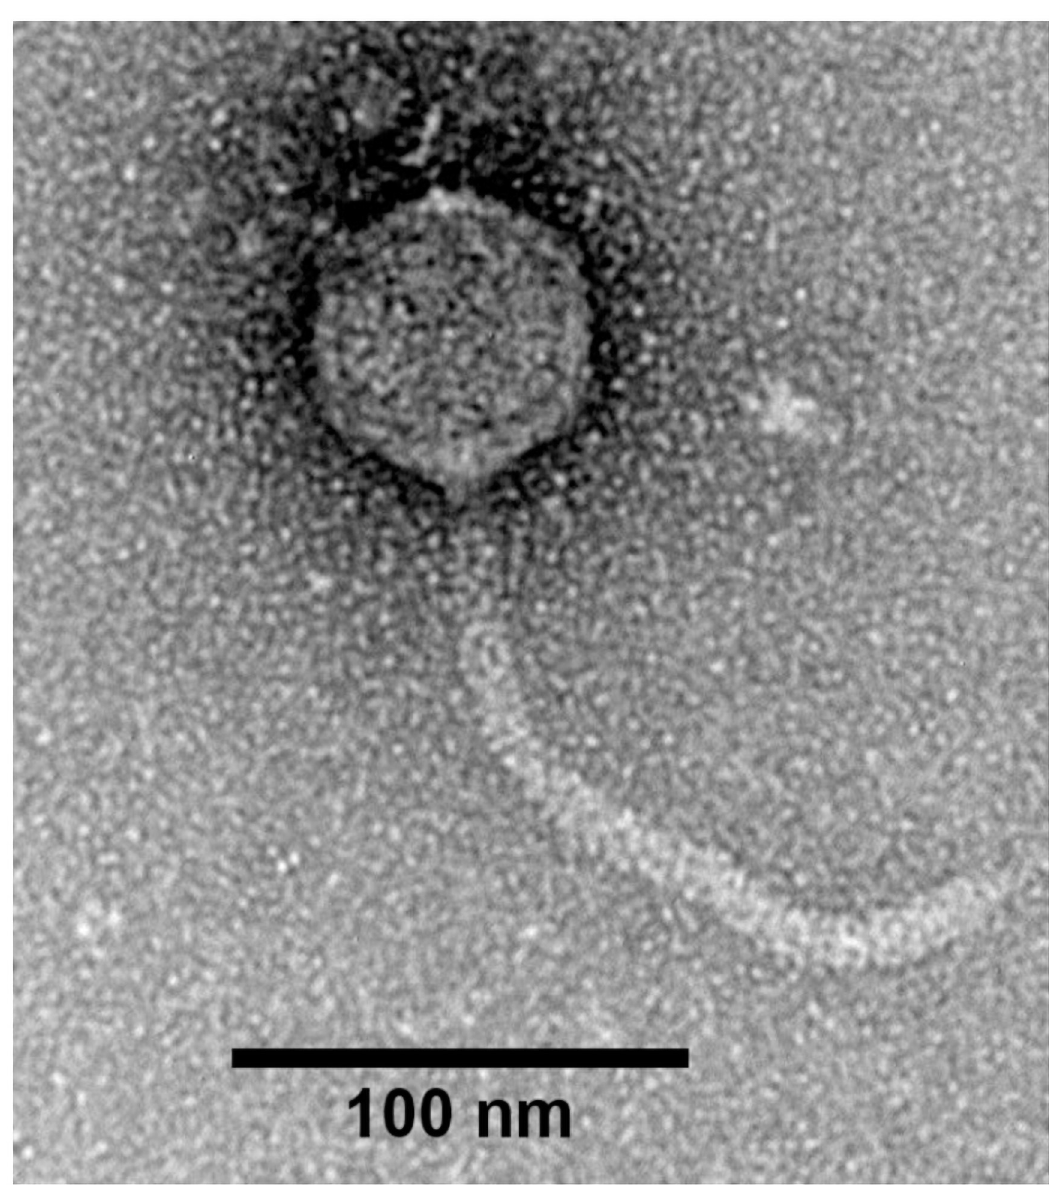
Fig 1. TEM characterisation of bacteriophage KMI8: Siphovirus with capsid length of 71nm ± 2nm; tail length and width approximately 190 nm ± 5 nm and 10 ± 0.1 nm, respectively.